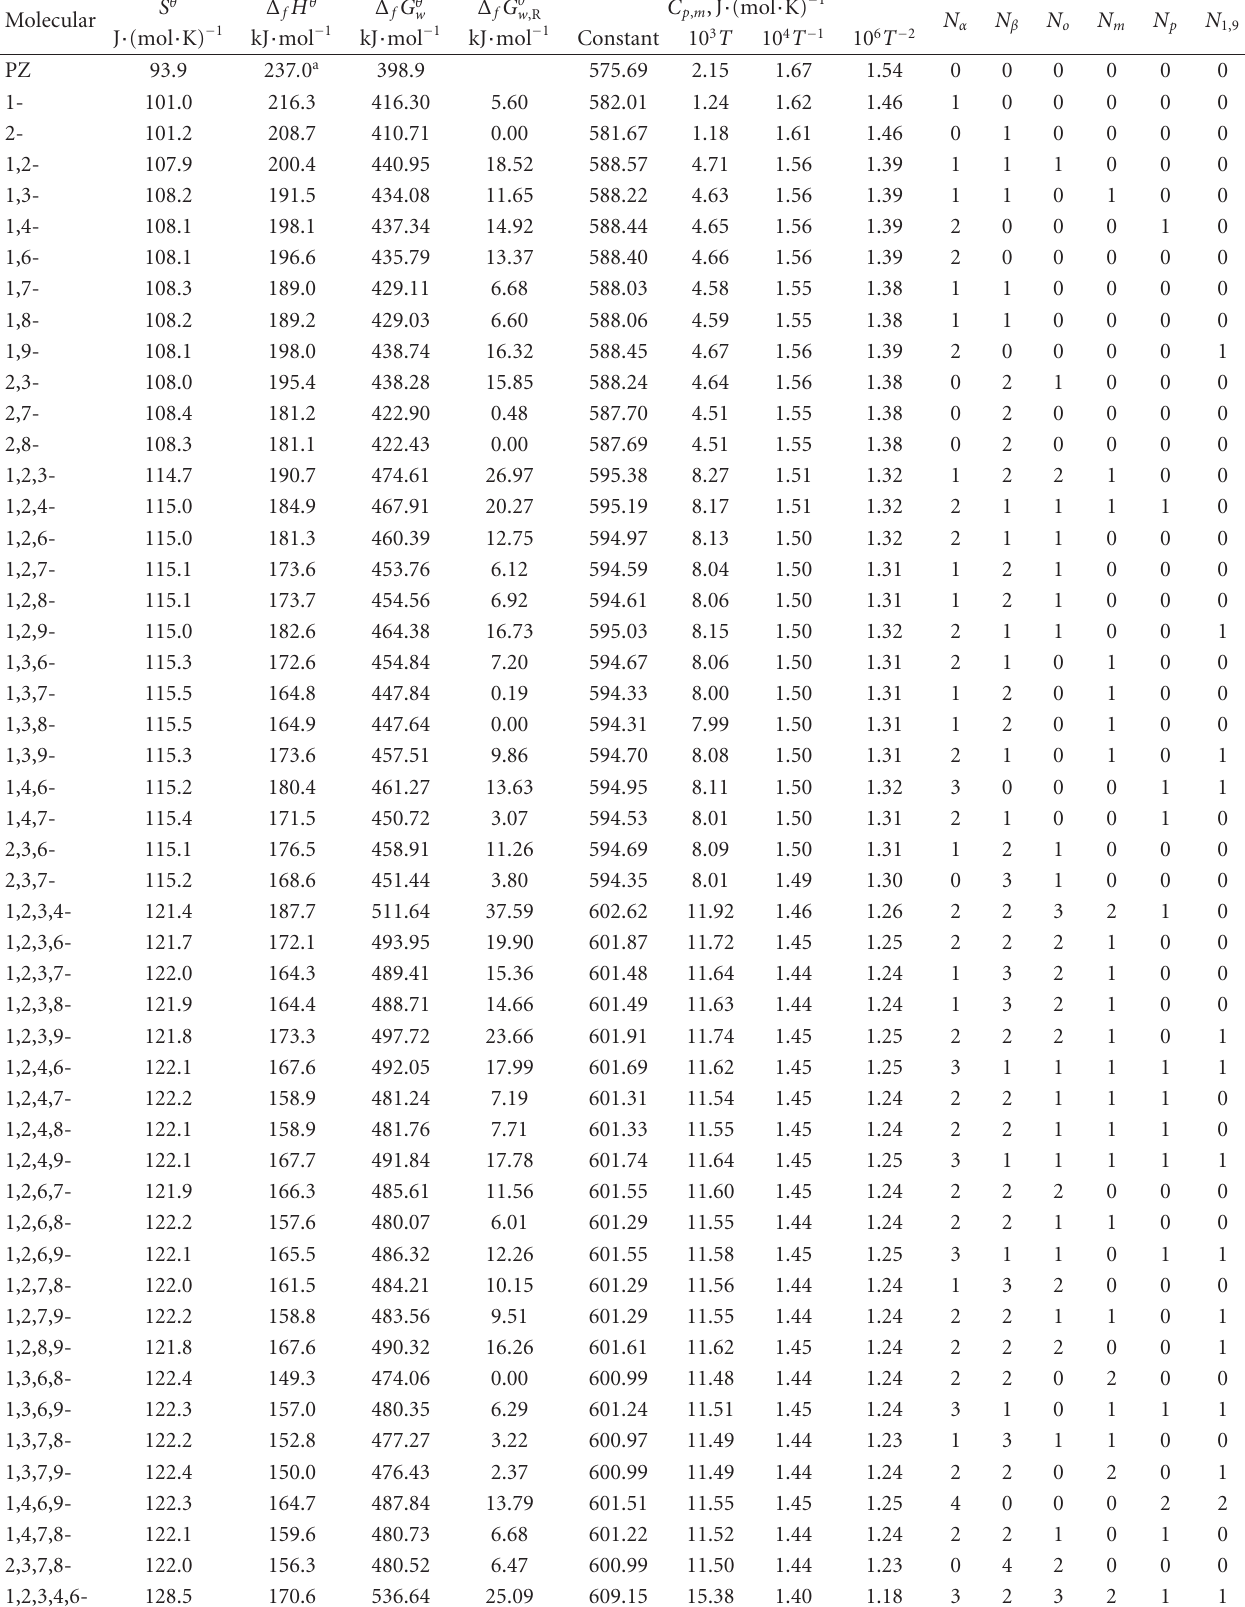
Table 3: Thermodynamic parameters by B3LYP/6-31G ∗ for